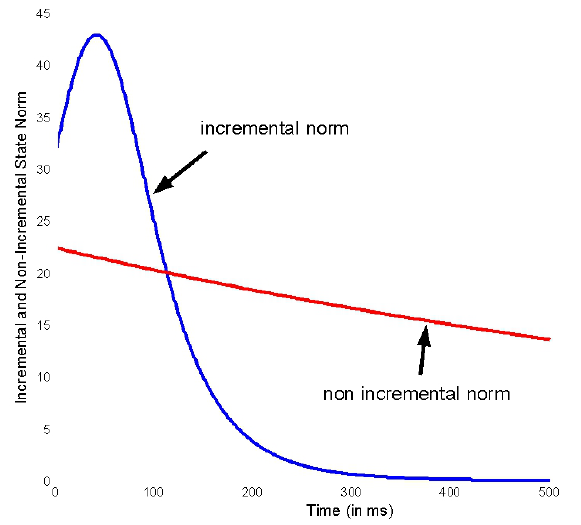
Figure 2: Incremental and non-incremental norms of system (28) with ( x s 1 (0) , y s 1 (0)) = ( − 20 , 10) and ( x s 2 (0) , y s 2 (0)) = (10 , 20). Jacobian